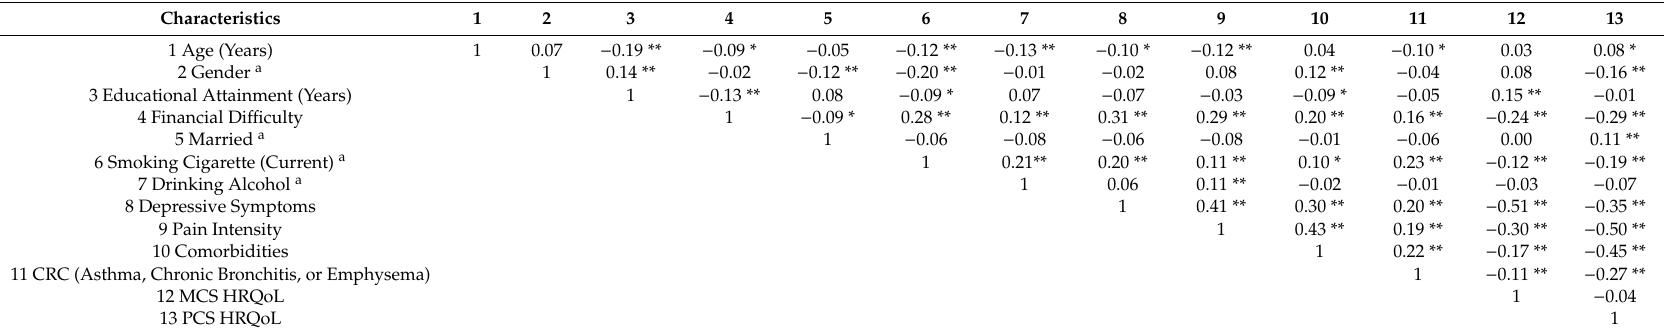
Table 2. Bivariate